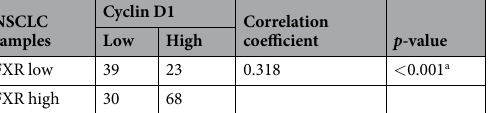
Table 4. Correlation analysis between FXR and cyclin D1 protein expression in NSCLC. a Data were analyzed using chi-square